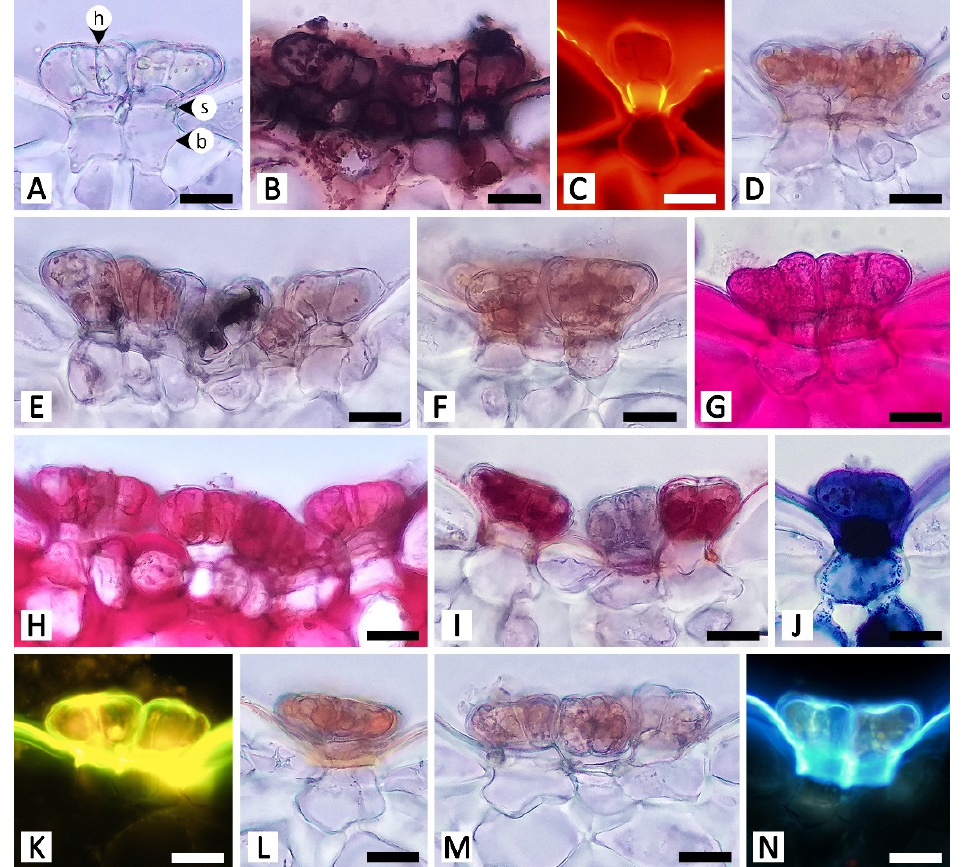
Figure 7. Histochemical results obtained from calycinal glands of Rivea ornata . ( A ) Unstained calycinal glands. ( B ) Sudan black B test for total lipids. ( C ) Neutral red fluorochrome test for total lipids. ( D ) Ferric chloride test for phenolic compounds. ( E ) Potassium dichromate test for phenolic compounds. ( F ) Lugol’s iodine test for starch. ( G ) Periodic acid–Schiff’s reagent (PAS) test for neutral polysaccharides. ( H ) Ruthenium red test for acidic polysaccharides. ( I ) Mercuric bromophenol blue test for proteins. ( J ) Nadi reagent test for terpenoids. ( K ) Naturstoff reagent A under fluorescent microscopy detecting flavonoids. ( L ) Dragendorff reagent test for alkaloids. ( M ) Wagner’s reagent test for alkaloids. ( N ) UV autofluorescence of calycinal glands. Note: ( B – E , G , H , J – M ) show positive reactions, while ( F , I ) show negative reactions. Abbreviations: b, base; h, head; s, stalk. Scale bars 20 μ m.